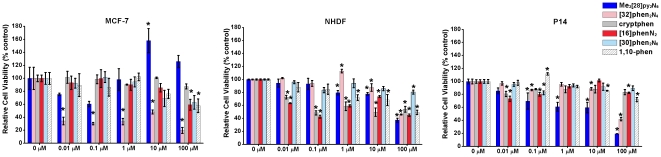
Relative cell viability of MCF-7, NHDF and P14 cells (0.5×104 cells/well) incubated with Me2[28]py2N6, [32]phen2N4, cryptphen, [16]phenN2, [30]phen2N6 and 1,10-phen, in concentrations ranging from 0–100 µM and using the MTT assay at 48 h, determining formazan absorbance at 570 nm.Mean values ± SEM are obtained from three experimental determinations. Data are expressed as a percentage of cell viability in comparison with the control; the bars represent the mean and the lines represent the SEM associated. *P<0.05 versus the control (one-way ANOVA with Dunnet's post-hoc test).